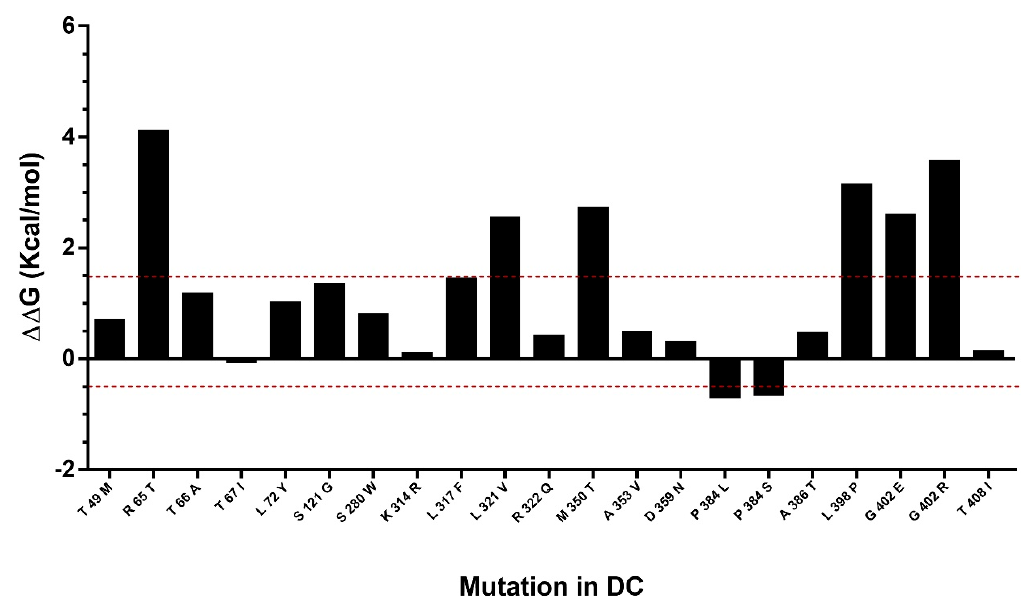
Figure 6. Analysis of mutation stability in the hDKC1 model by Foldx software. Mutations comprised between red dashes lines ( − 0.5 Kcal/mol to 1.5 Kcal/mol) correlates with the mutations that are not destabilizing. DC = dyskeratosis congenita.